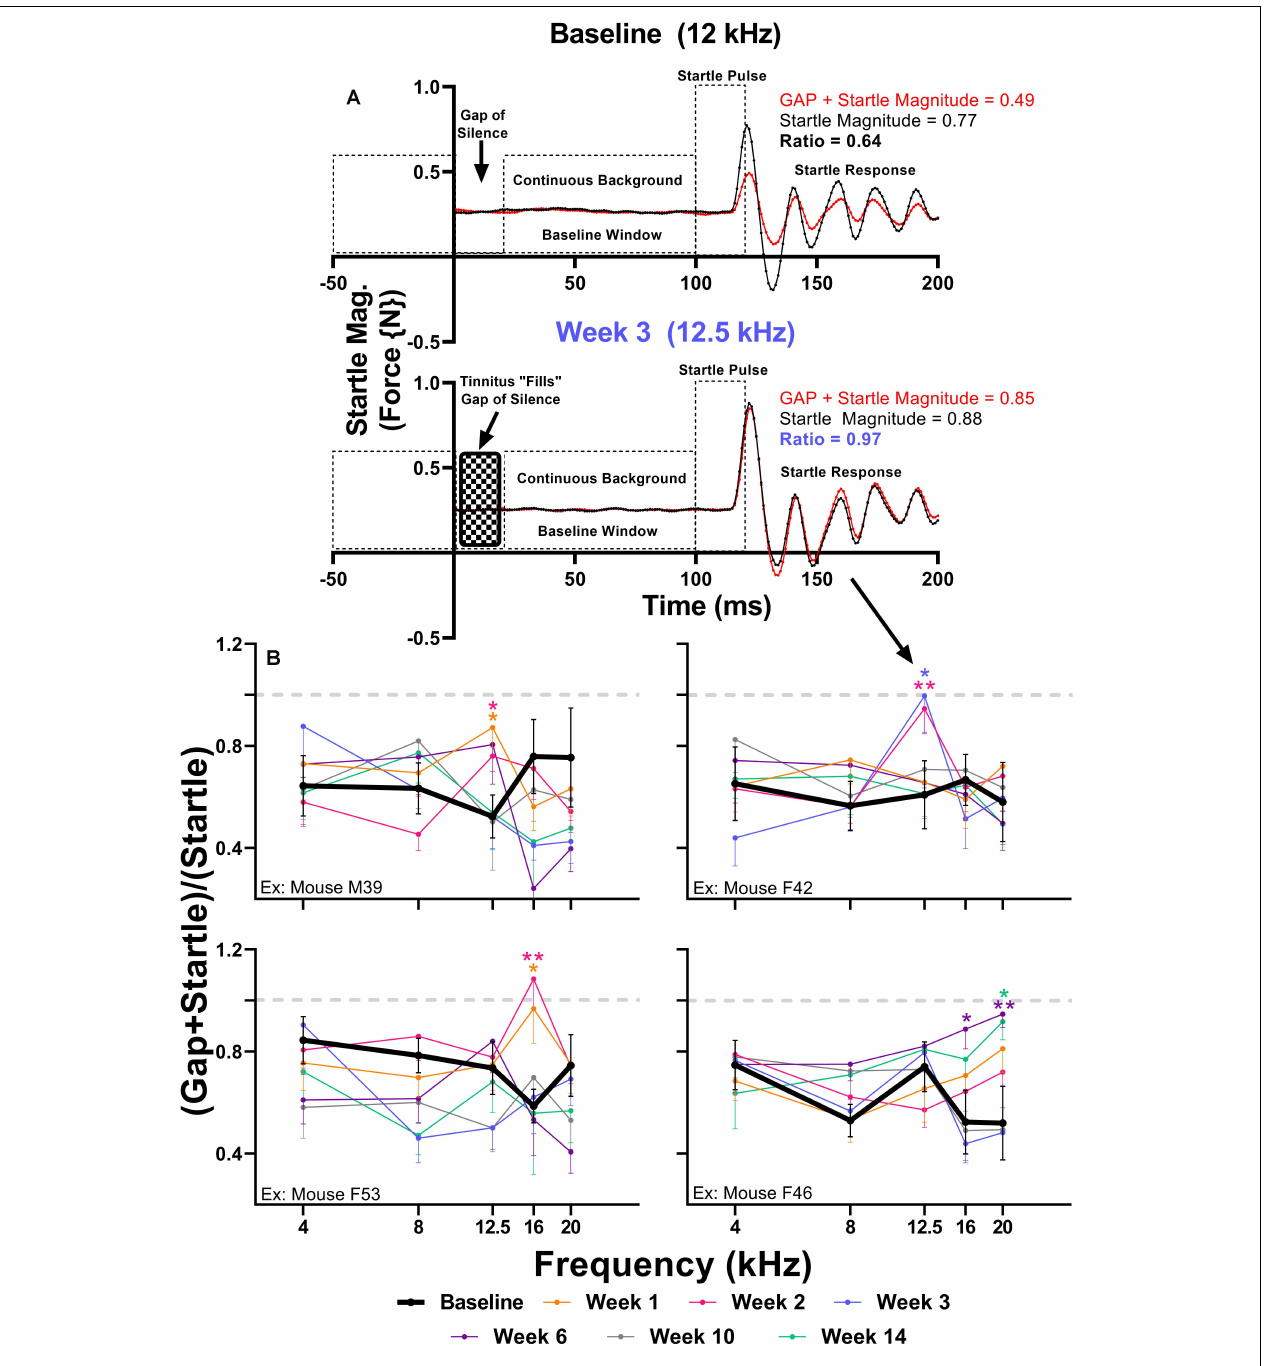
FIGURE 7 | (A) Diagram of the GPIAS paradigm, including the stimuli used and the corresponding animal reactions. Representative GPIAS trial data from baseline and week 3 from an animal (mouse F42) which developed tinnitus at 12.5 kHz after amikacin treatment. The top panel (baseline) shows that a gap of silence embedded in a continuous background noise preceding a startle stimulus can reduce the startle response (red line) when compared to a situation when no gap is present (black line). In the bottom panel (week 3) the gap of silence is filled with tinnitus, resulting in diminished gap detection represented by a GPIAS ratio approaching 1.0. (B) GPIAS assessments in 4 (out of 17) mice with behavioral evidence of tinnitus. Tinnitus was defined as consistent and significant GPIAS deficit at 1 or 2 adjacent frequencies at weeks 1, 2, 3, 6, 10, or 14 when compared to baseline GPIAS performance. Data are represented by ratio means and standard errors. Post hoc significant differences between specific epochs (color coded) and baseline are indicated as follows: ∗ p ≤ 0.05; ∗∗ p ≤ 0.01. The dashed gray line (equaling a ratio of 1) represents no gap detection.